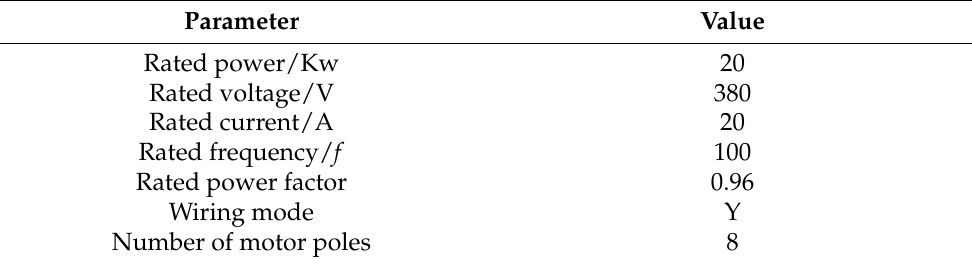
Table 14. Main parameters of the prototype.